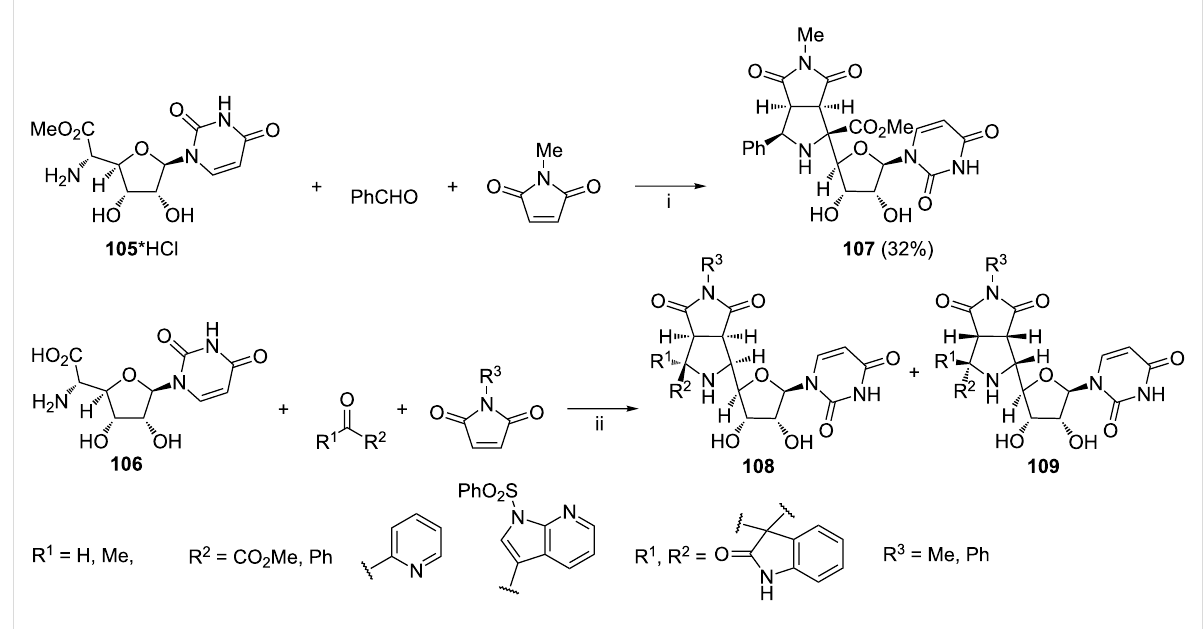
cycloaddition of the ylide to N -methylmaleimide. The forma- tion of compound 107 as the only product was rationalized using semi-empirical calculations. In the same contribution, the cascade reactions starting from uracil polyoxin C 106 were described (Scheme 44). Decarboxylative formation of azome- thine ylides from 106 and an aldehyde (or ketone), followed by reaction of the ylide with maleimide afforded mixtures of cycloadducts 108 and 109 in molar ratios varied from 1:1 to 12:1. Compounds 108 were inactive against Aspergillus fumi- gatus or Candida albicans at concentration of 125